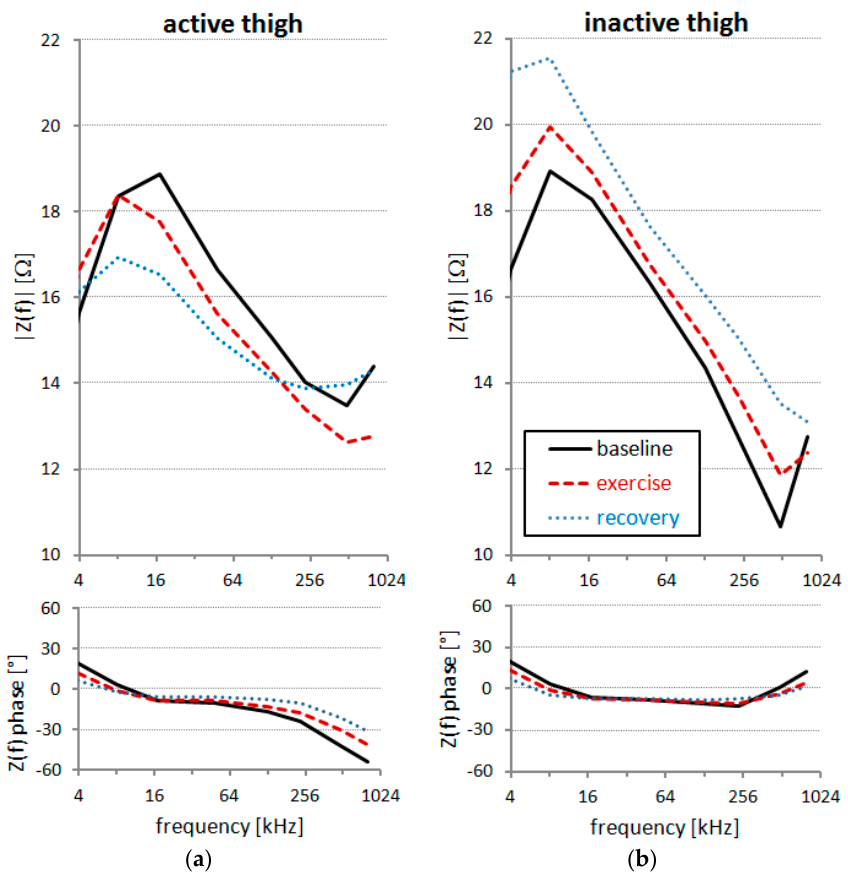
Figure 7. Z (f) during the leg-extension test in “baseline”, “exercise” and “recovery” periods in sitting position: ( a ) active thigh; ( b ) inactive thigh.